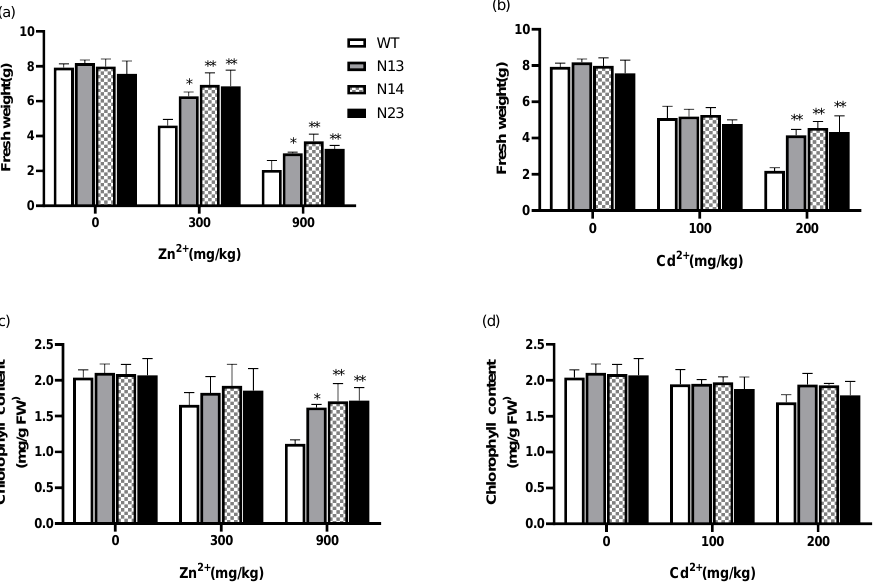
Figure 3. The fresh weight and chlorophyll content under Zn 2+ or Cd 2+ stress. ( a ) Fresh weight of the WT and transgenic lines under Zn 2+ at different concentrations. ( b ) Fresh weight of the WT and transgenic lines under Cd 2+ stress at different concentrations. ( c ) Chlorophyll content of the WT and transgenic lines under Zn 2+ Cd 2+ stress at different concentrations. ( d ) Chlorophyll content of the WT and transgenic lines Cd 2+ stress at different concentrations. WT: Wild-type tobacco. N13, N14, N24: Three homozygous transgenic tobacco lines (T 2 ). The 4 − week − old WT and transgenic plants were treated under Zn 2+ (0, 300, or 900 mg/kg) or Cd 2+ (0, 100, or 200 mg/kg) for 3 weeks, respectively. Asterisks indicate a significant difference between transgenic lines and WT (*, p < 0.05; **, p < 0.01).